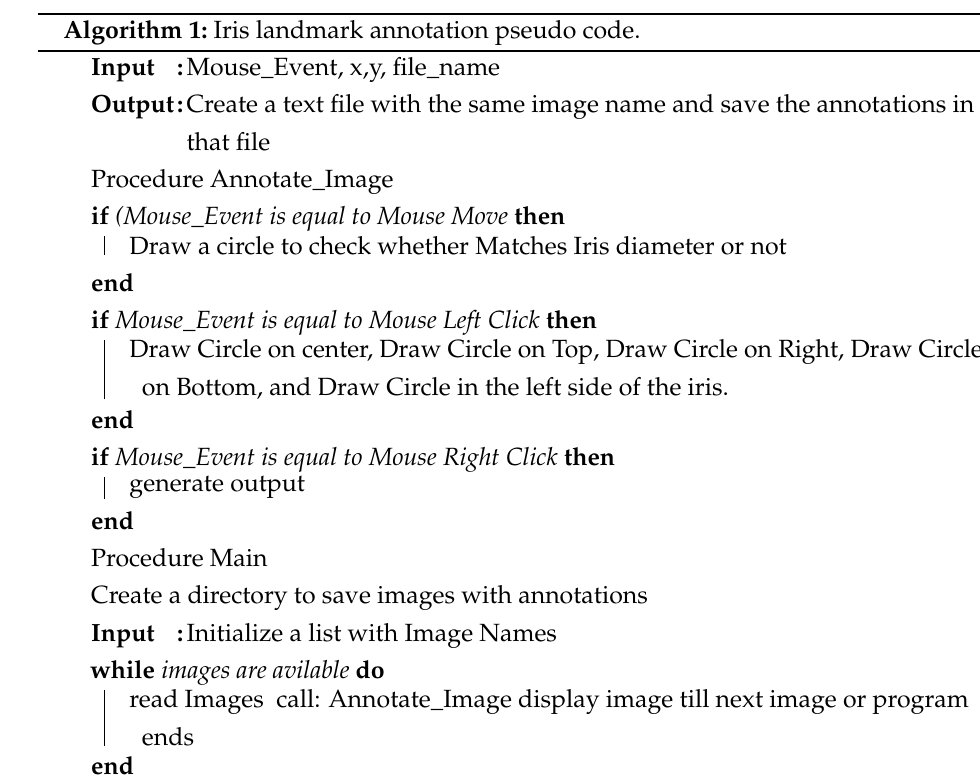
Algorithm 1: Iris landmark annotation pseudo